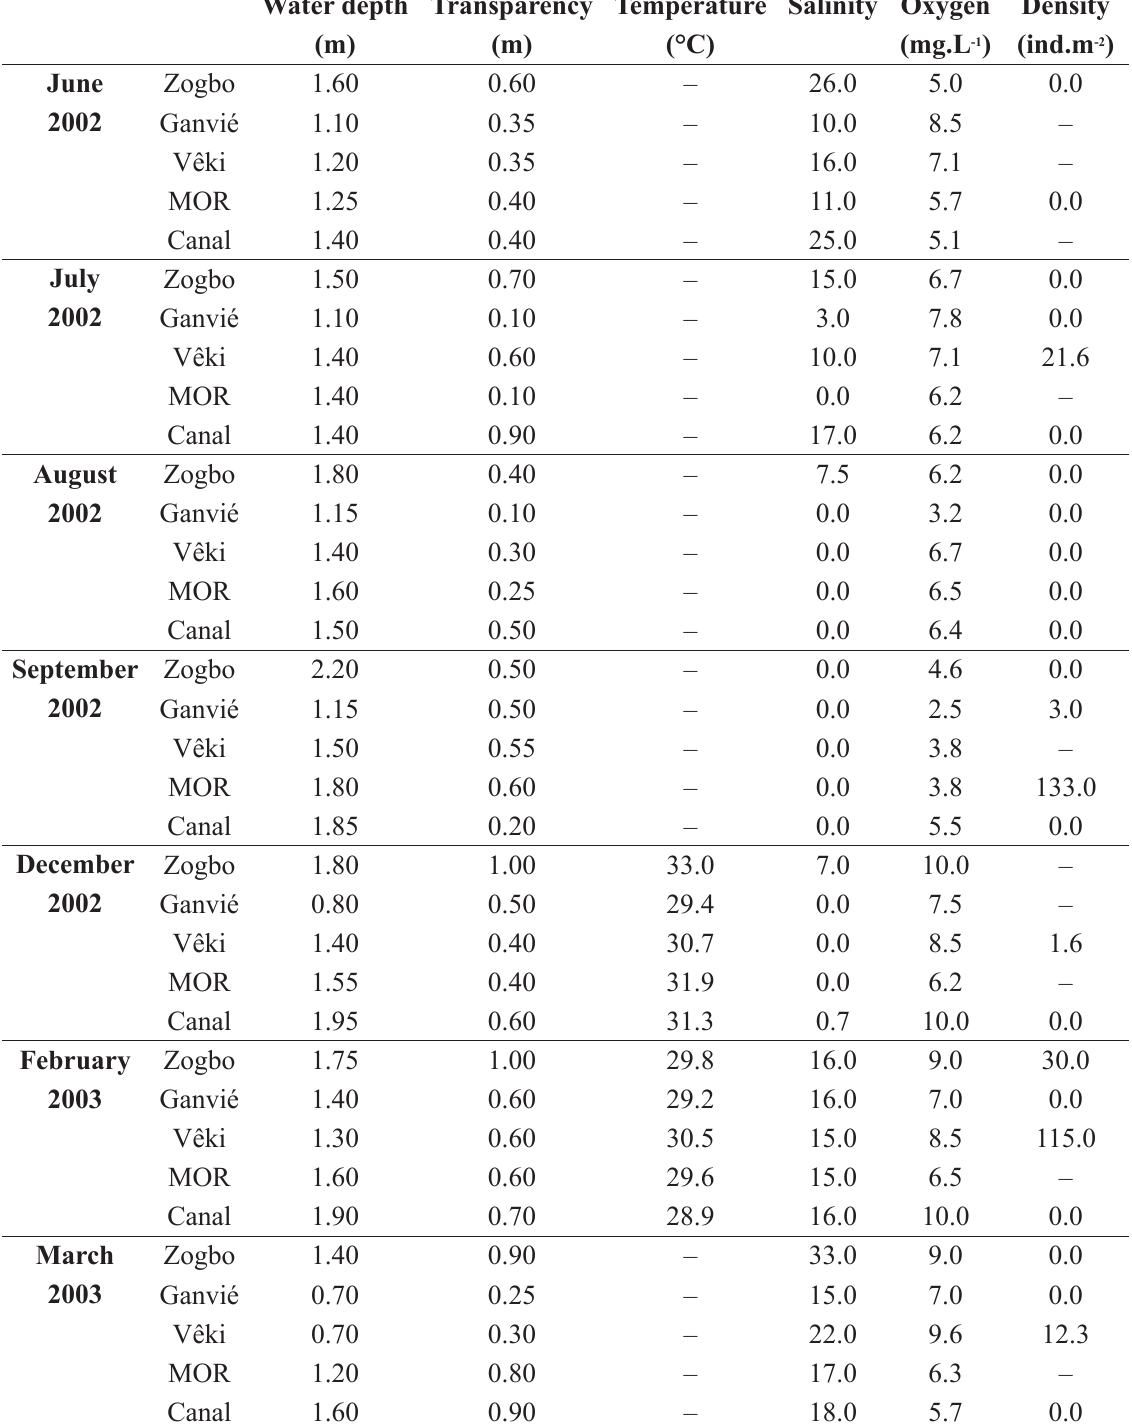
Table 1. Relationship between abiotic environmental variables and densities of the amphipod Quadrivisio laleyei sp. nov. sampled in 2002–2003 at five stations of the Nokoué lagoon (basket sampling method; mean of three replicates at each